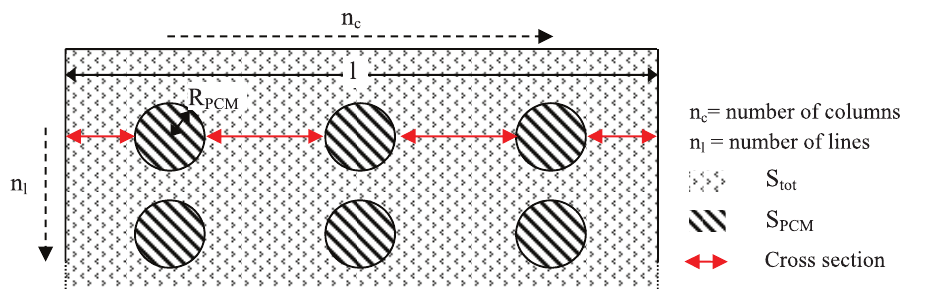
Fig. 10: Illustration for the calculation of the cross section coefficient